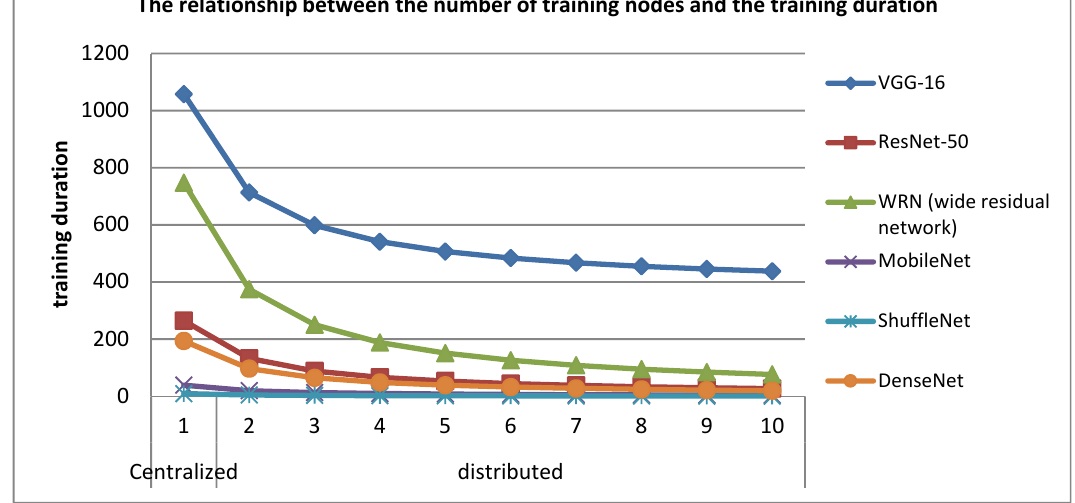
Figure 8. The relationship between the number of training nodes and the training duration.